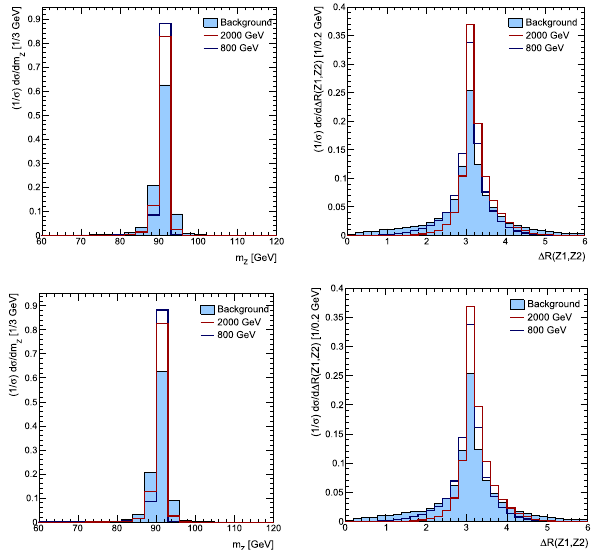
Fig. 12 Invariant mass of the reconstructed Z boson candidates in the events (left) and angular separation ( Δ R ( Z 1 , Z 2 ) ) between the two reconstructed Z bosons (right) at 14 TeV (up) and 100 TeV (down). The peak at ∼ 3 in Δ R ( Z 1 , Z 2 ) distributions both for signal and background show that the Z bosons are produced mostly back-to-back